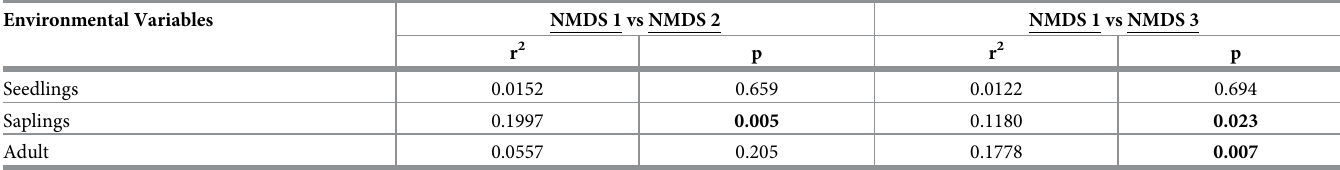
Table 1. Squared correlation coefficients and associated p-values from permutation tests of the associations between O . europaea life-stage abundances and NMDS axes. Environmental Variables